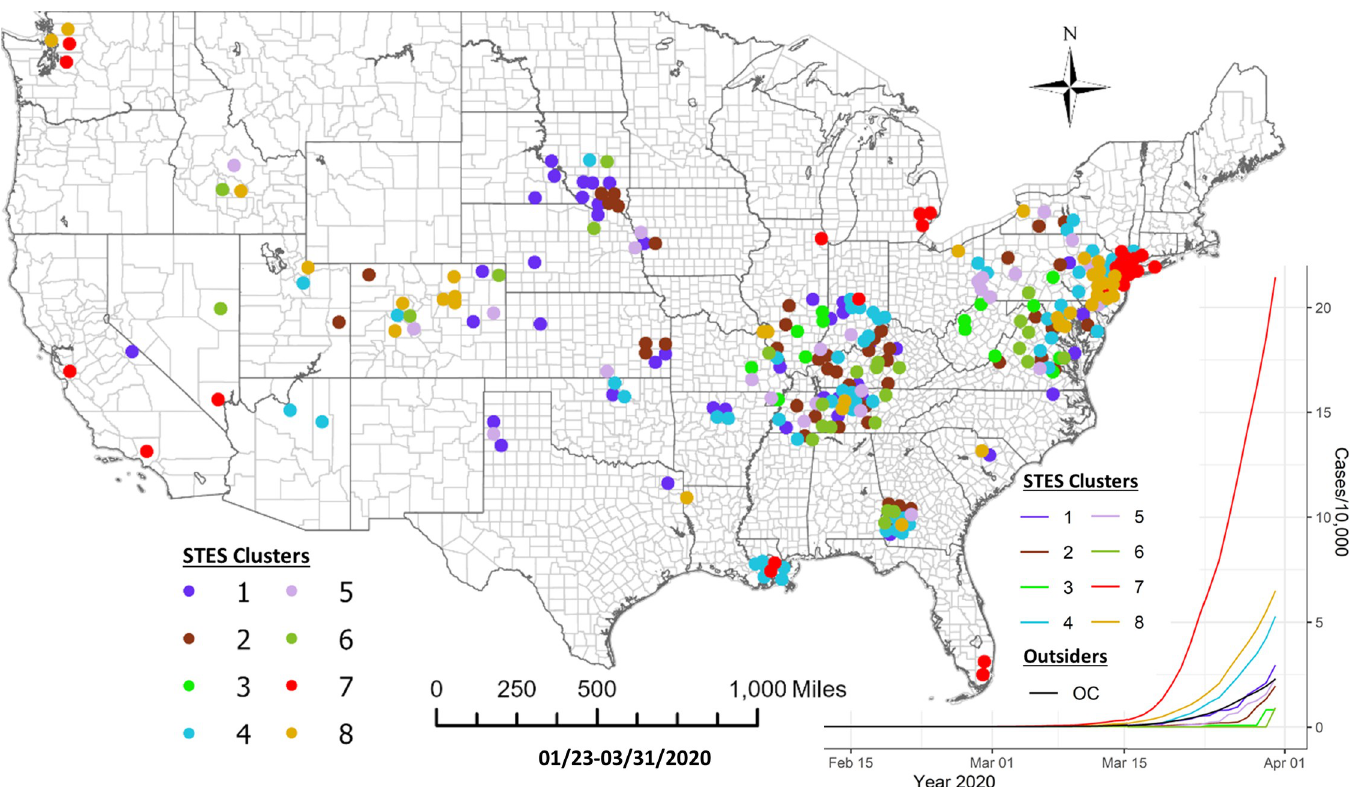
Fig 6. Sequence similarity-based COVID-19 clusters along with average temporal trends at county level during 1/22/2020-3/31/2020. This map includes the counties with higher relative risk (RR > 1) contained in all the clusters detected by scan statistics in Fig 3. The average temporal trends of cumulative cases for STES clusters 1–8 on the map appear at the bottom right. Notice that the colors of STES clusters match with correspondingly colored dots on the map and with the colors of the STES cluster curves on the graph. OC includes all counties not included in the clusters.